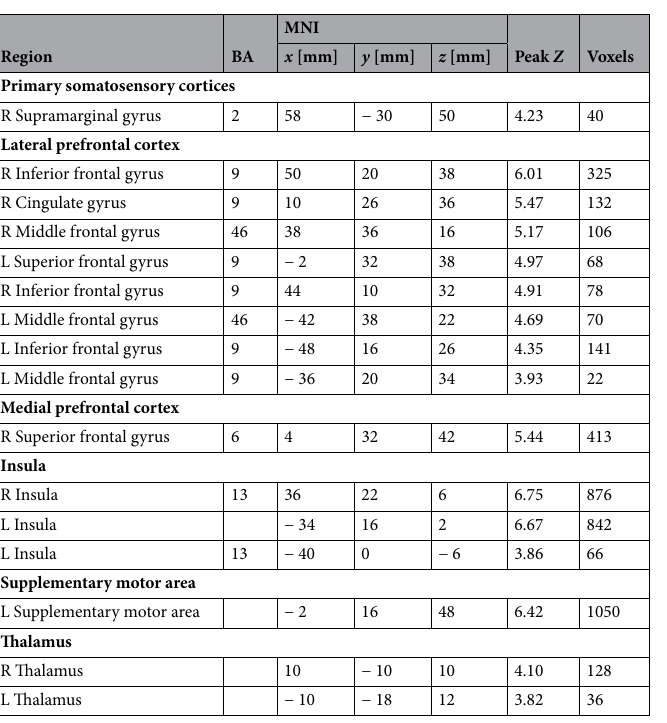
Table 2. MNI coordinates of the activated clusters in trial 2. In this trial, a stimulation current amplitude that was 1.0 times that of the standard amplitude was applied. Threshold values of uncorrected p and cluster extent k were set as smaller than 0.001 and more than 20, respectively. L left hemisphere; R right hemisphere.